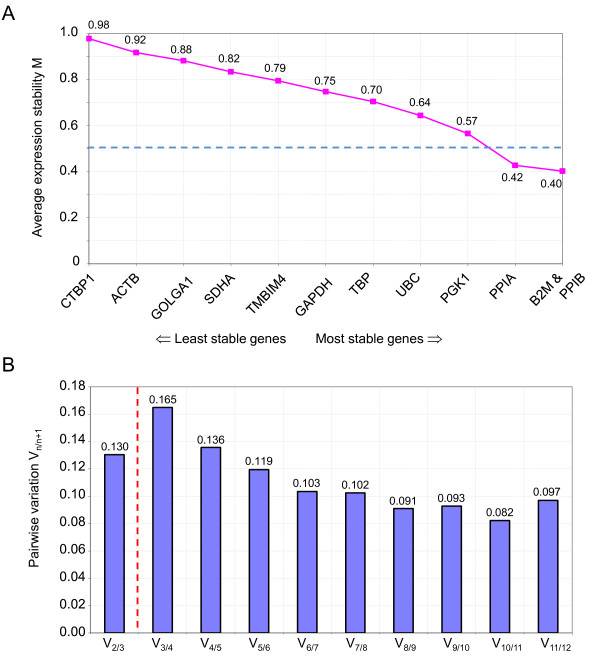
geNorm analysis. (A) Average expression stability M of all remaining control genes after stepwise exclusion of the least stable reference genes. More stably expressed genes are positioned on the right side of the diagram, less stably expressed on the left side. Candidate reference genes with a mean stability value M < 0.5 are regarded as stably expressed [20] as indicated by a blue, dashed line. (B) Determination of the optimal number of control genes required for reliable normalization by stepwise calculating the pariwise variation (Vn/n+1) between normalization factors based on the n and (n+1) most stably expressed reference genes based on results results from (A). According to the developers of geNorm, a variation < 0.15 indicates no significant contribution of an additional control gene to the normalization factor and the optimal number of control genes as shown by a red, dashed line.